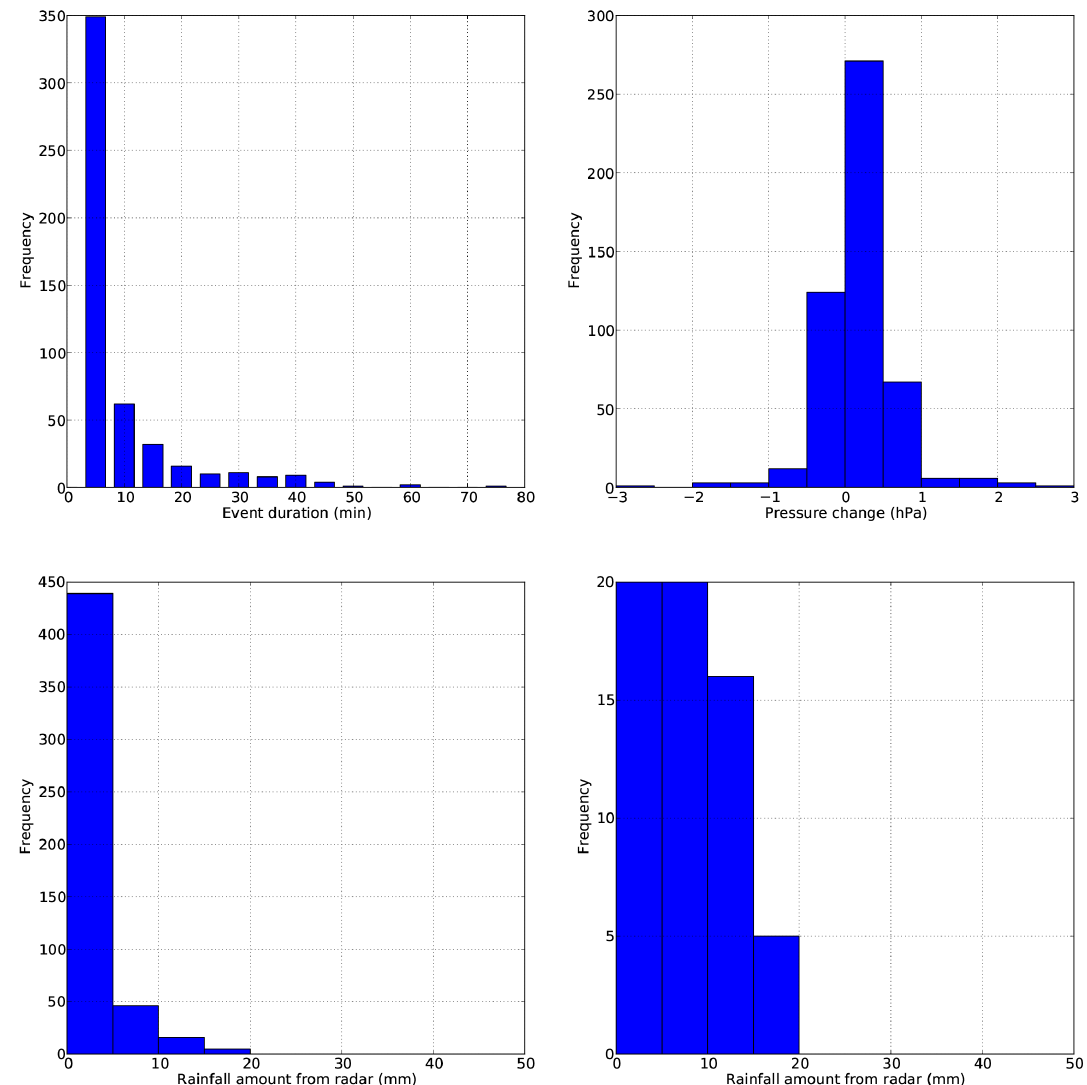
Figure 5. Frequency distribution of duration, pressure change and radar rainfall amounts (with two different frequency maximum ranges) based on 506 intense rainfall events. Table 1. Statistics based on 145 valid pairs with radar and gravimeter rainfall amounts both exceeding 2mm. Mean bias = sum(Ri − Gi)/sum(Gi), where Ri and Gi are the radar and gravimeter rainfall amounts. MAD is the mean absolute difference and RMSE the root mean square